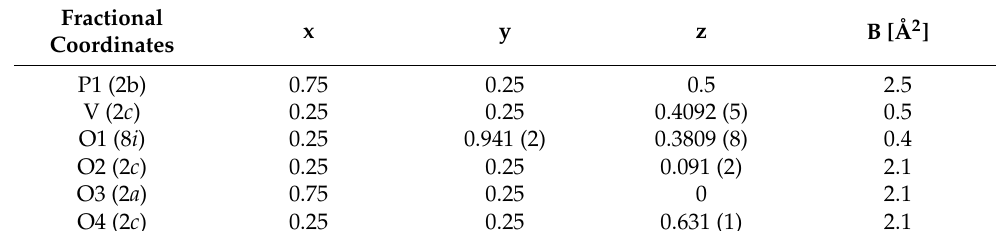
Table 2. Fixed and refined fractional atomic coordinates. Table 1. The main results of the refinement in the space group P4/ nmm Z.